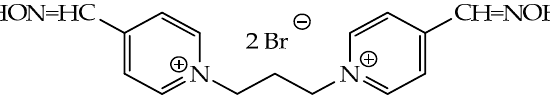
Figure 2. Chemical structure of trimedoxime.